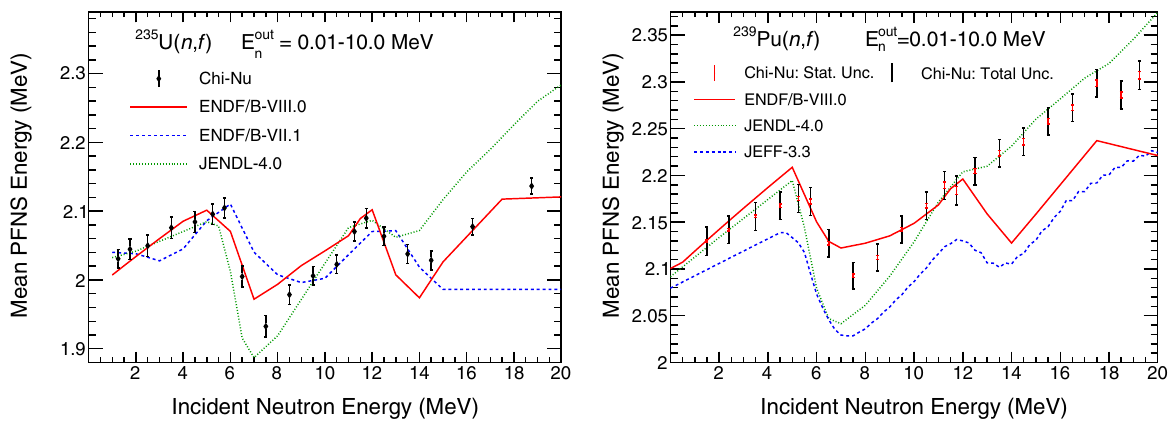
E , as a function of E inc is shown here for 235 U and 239 Pu in the left and right panels, n (cid:31) (cid:30) E uncertainties are also subdivided into statistical (cid:31) (cid:30)